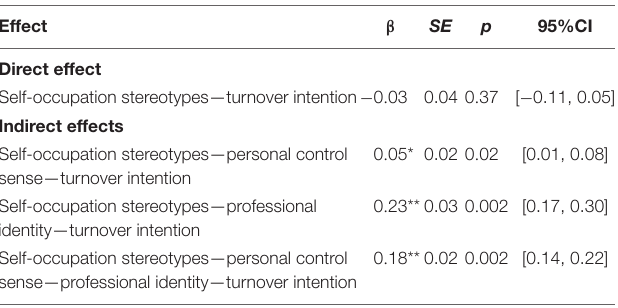
TABLE 2 | Direct and indirect effects between self-occupation stereotypes and turnover intention in the multiple model. Effect β